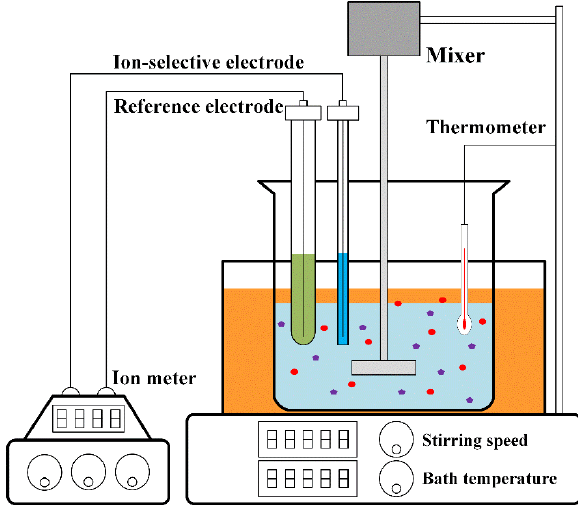
Figure 1. Diagram of the in-situ monitor leaching system.